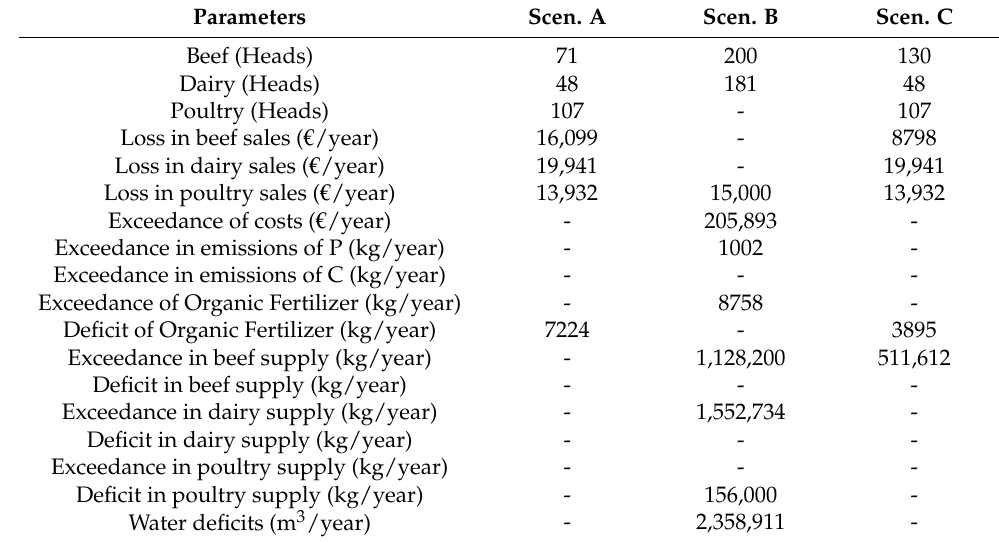
Table 6. Results of the ESCA model per